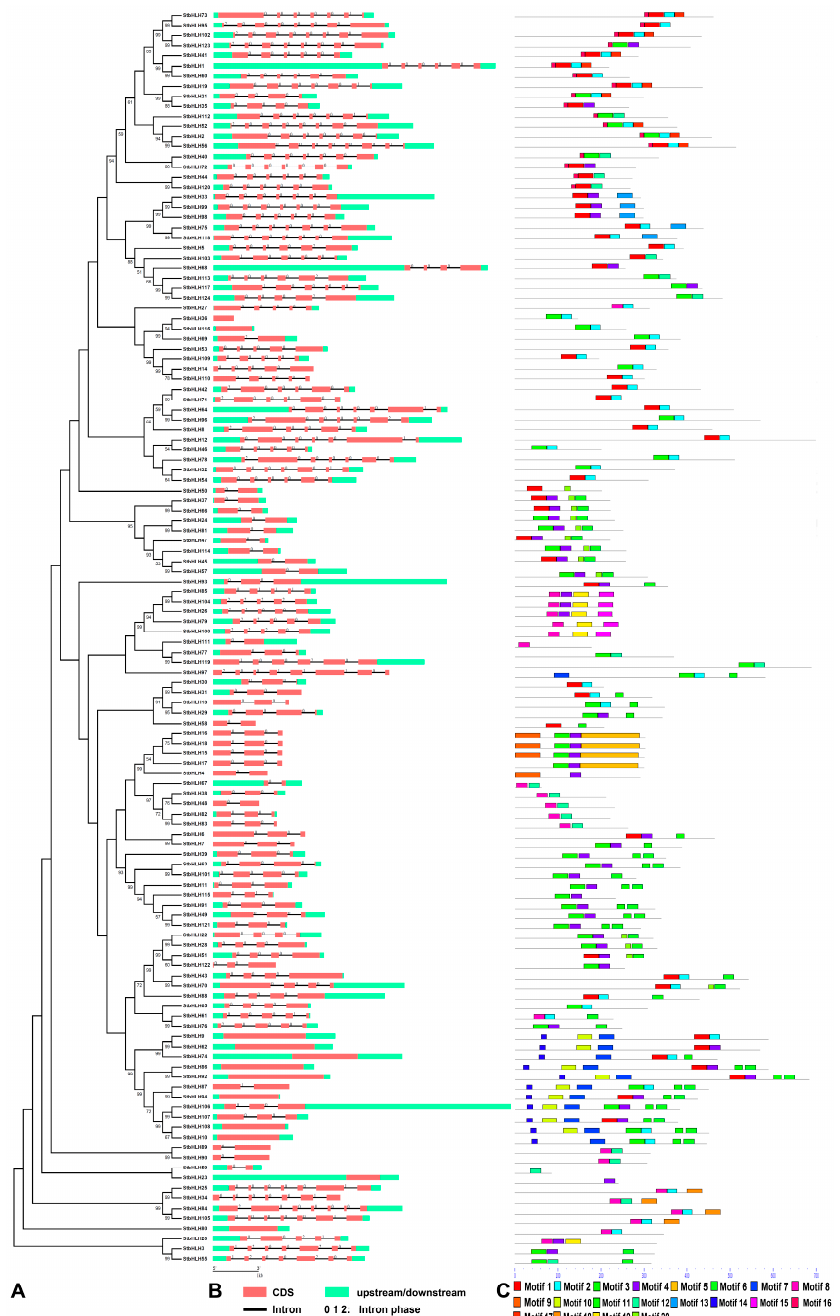
Figure 1. Gene structures of Solanum tuberosum basic/helix–loop–helix ( StbHLH ) genes and phylogenetic relationships, conserved motifs of StbHLH proteins. ( A ) Phylogenetic tree of 124 StbHLH proteins. The unrooted Neighbor-joining phylogenetic tree was constructed with MEGA6 [61] software using the full-length amino acid sequences of 124 StbHLH proteins. ( B ) Exon–intron organization of StbHLH genes. Red boxes represent exons and black lines of the same length represent introns. The upstream and downstream regions of StbHLH genes are indicated by green boxes. The numbers 0, 1 and 2 represent the intron phases. The sizes of exons can be estimated by the scale at bottom. ( C ) Arrangements of conserved motifs in the StbHLH proteins. Twenty predicted motifs are represented by different colored boxes, and motif sizes are indicated by the scale at bottom. For motif details refer to Table 1. CDS: coding